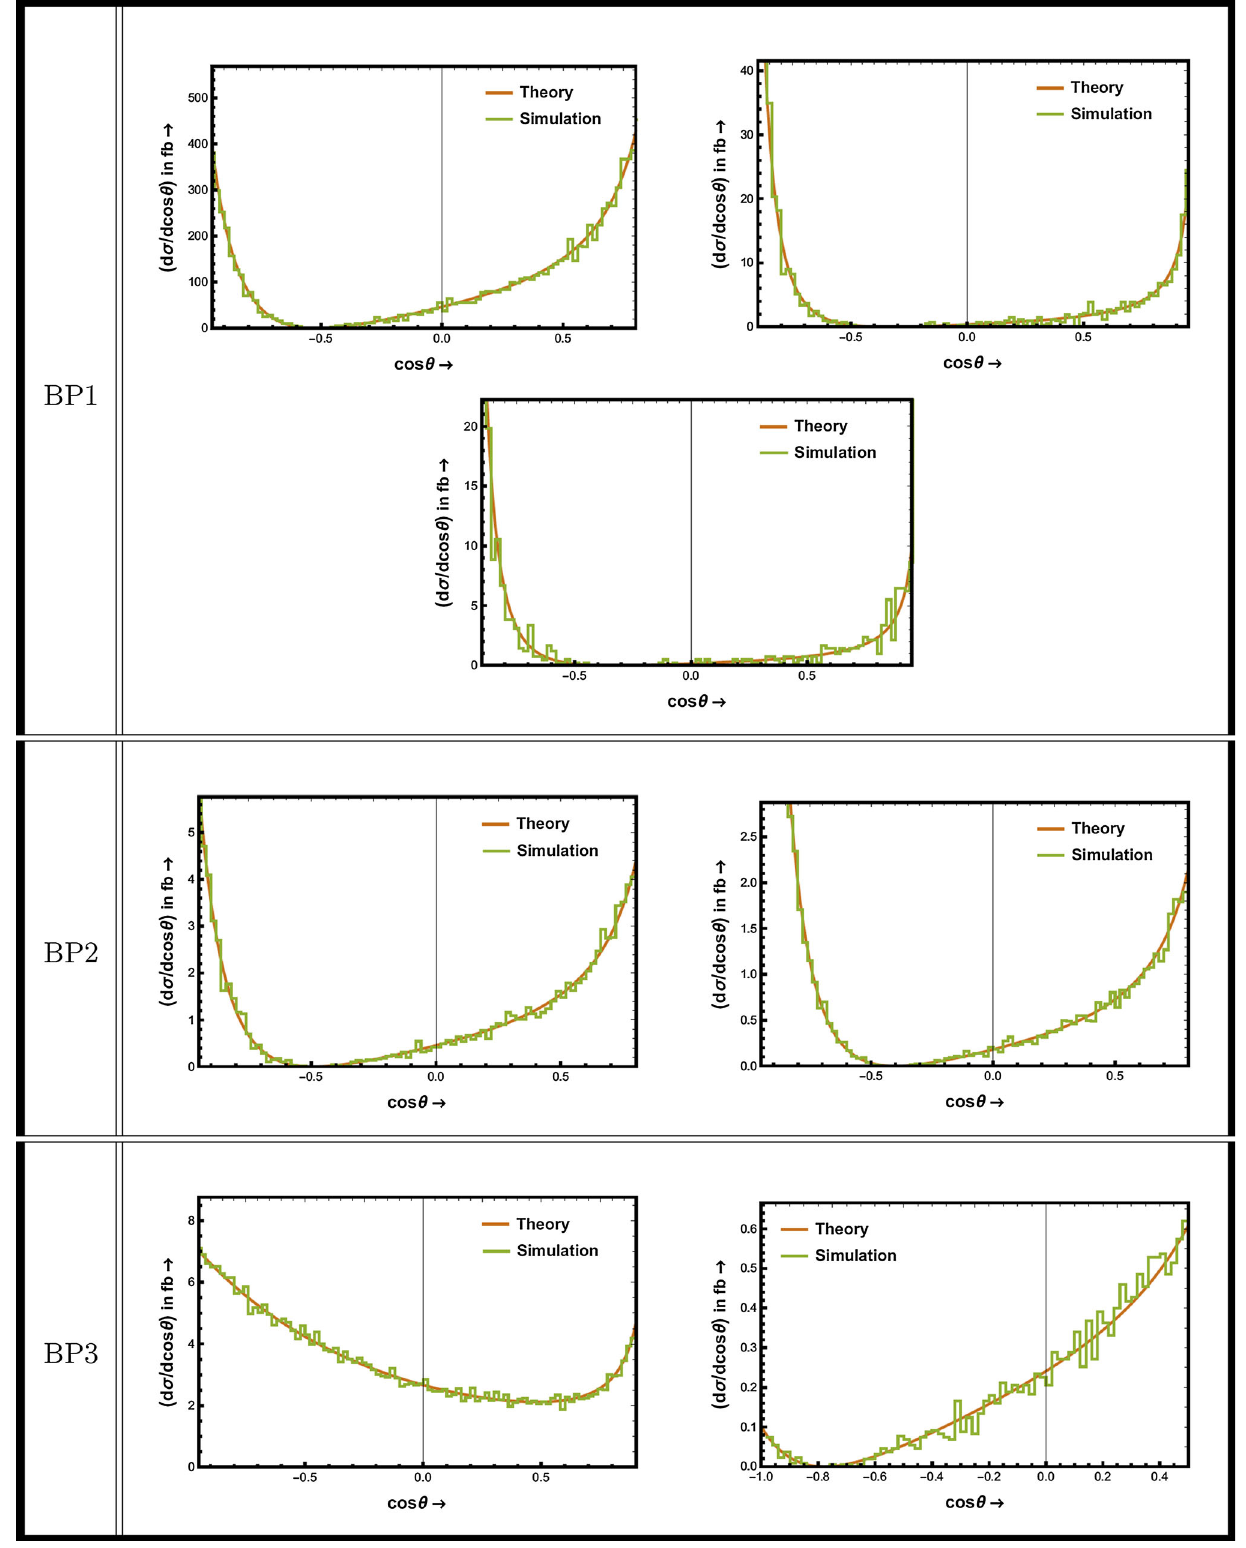
/ 3 ) c at various center of momentum energies for different benchmark points, arranged in the 2 μ